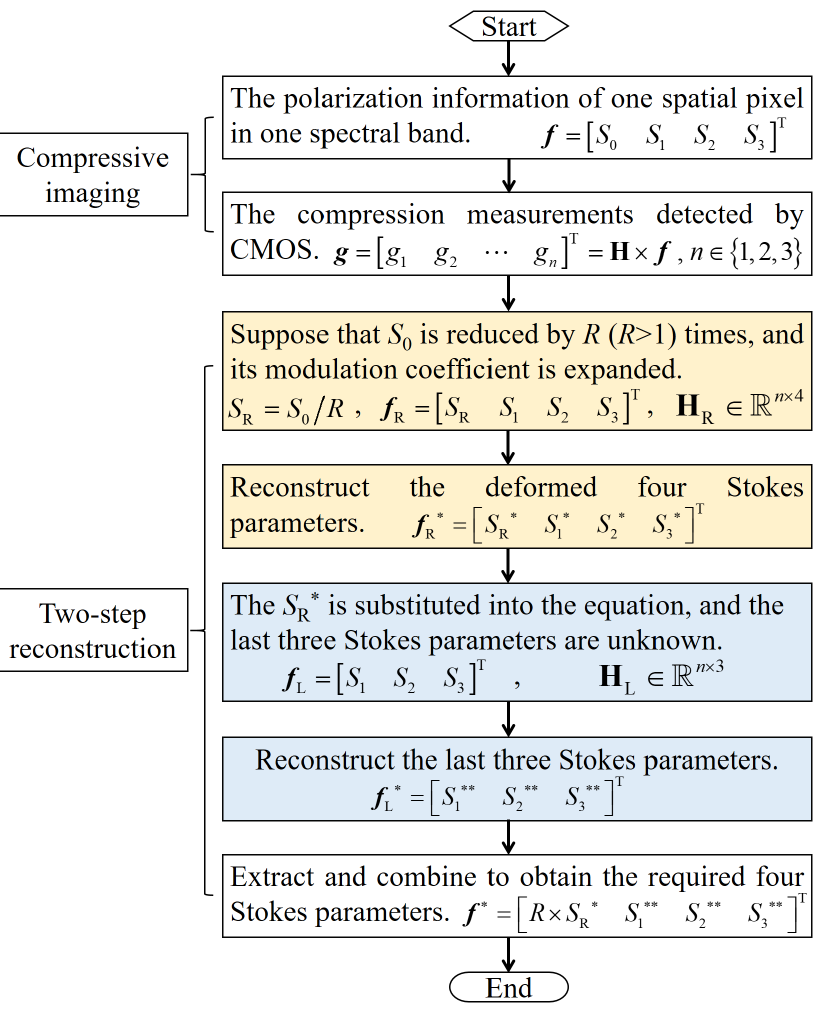
Figure 2. The flowchart of full polarization compression and